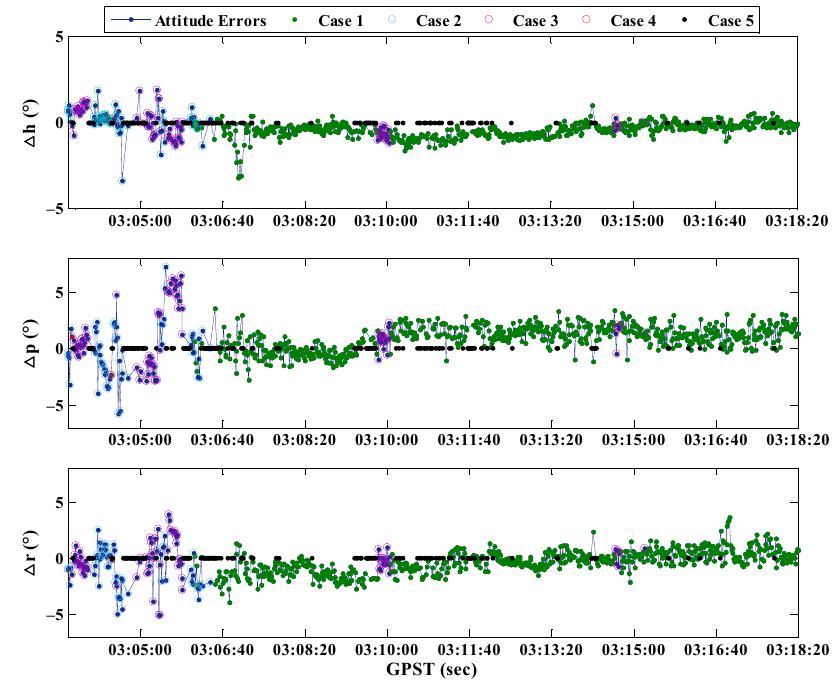
Figure 13. Attitude determination errors obtained by the assistance of BCAFM.